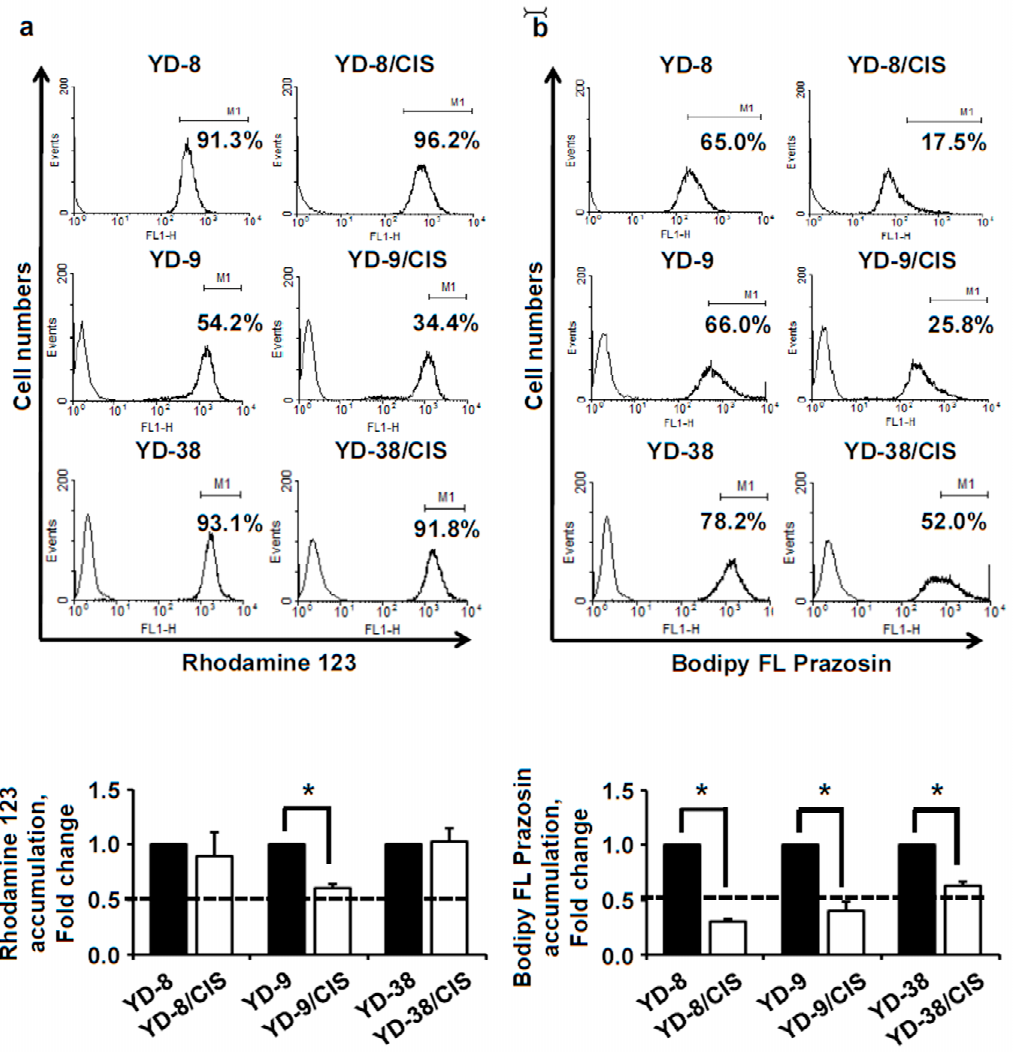
Figure 3. Functional assay for multidrug resistance protein1 or P glycoprotein (MDR1) and breast cancer resistance protein (BCRP) expression in parental and cisplatin-resistant OSCC cell lines. ( a ) Top, a rhodamine123 assay was used to monitor MDR1 activity. Bottom, data represent the quantitative results for the top panel. ( b ) Top, a prazosin assay was used to monitor BCRP activity. Bottom, data represent the quantitative results for the top panel. Cells were incubated for 30 min with growth medium alone (blank, thin solid line), or 1 µ g / mL rhodamine123, or 250 nM prazosin (heavy solid line). Cisplatin treatment is su ffi cient to induce MDR1 activity in YD-9 cells and BCRP activity in YD-8, YD-9, and YD-38 cells (mean ± SD; n = 3). * p < 0.01 versus parental